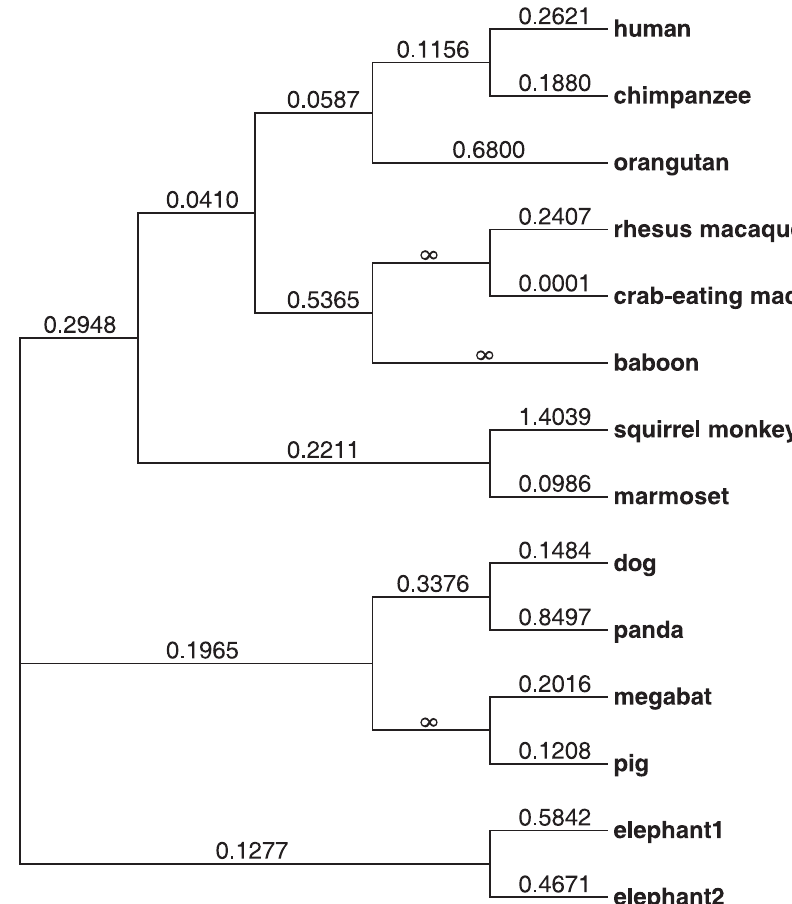
Figure 1. Phylogenetic tree showing the dN/dS ratio of each lineage analyzed.